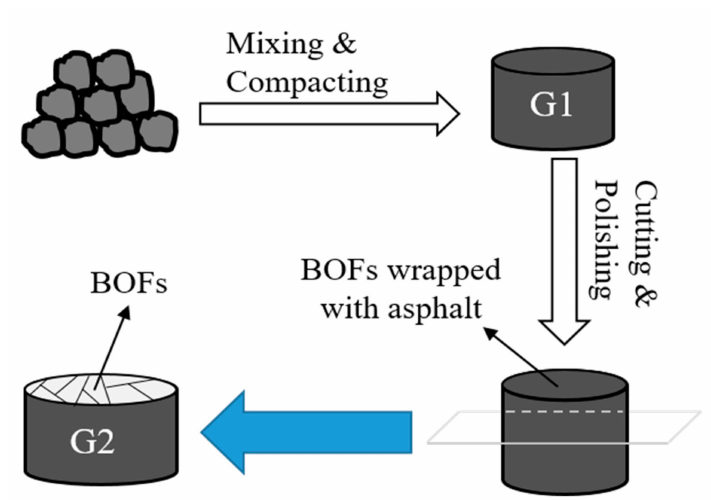
Figure 2. Preparation of the tested samples for the monolith